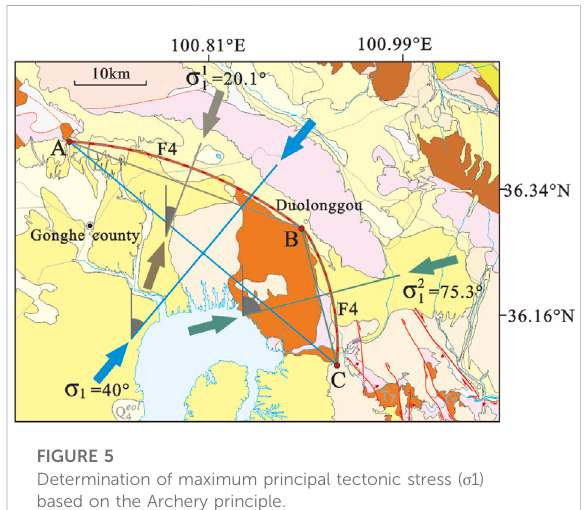
FIGURE 5 Determination of maximum principal tectonic stress ( σ 1) based on the Archery